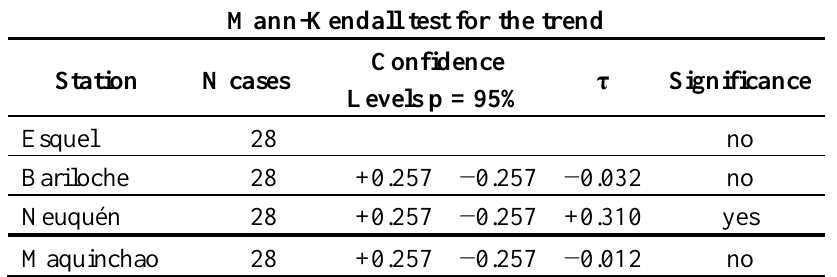
Table 3. Results of Mann-Kendall test for assessing a trend in the July